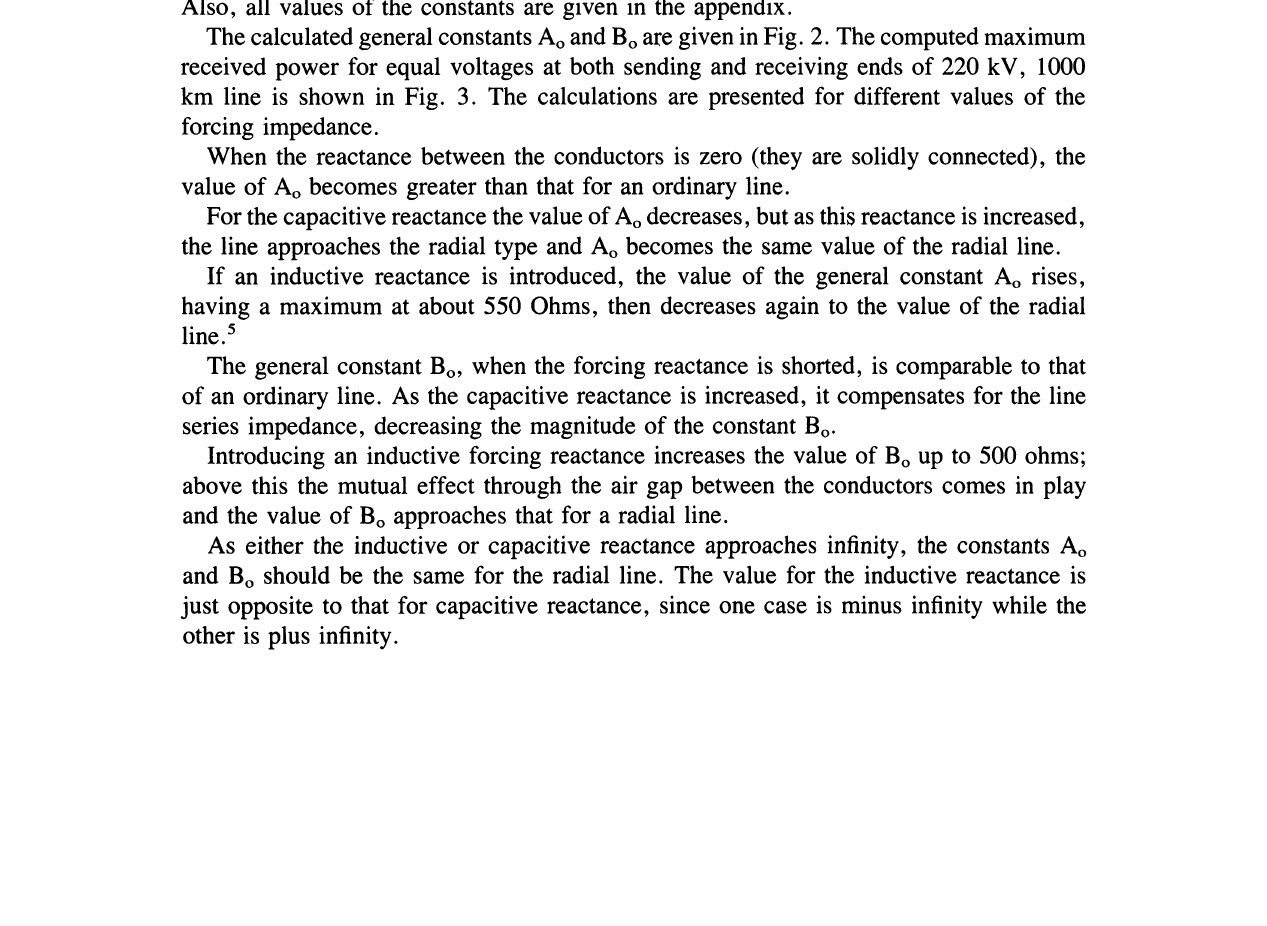
FIGURE 2 The general constants Ao and Bo of a 1000 km